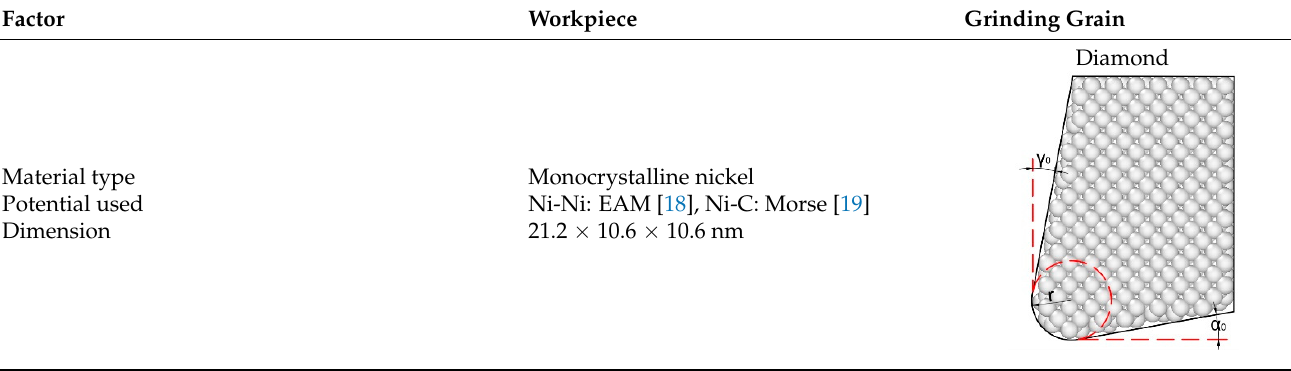
Figure 2. Molecular dynamics models of different tool shapes. Table 1. Set-up conditions of grinding monocrystalline nickel molecular dynamic simulation.